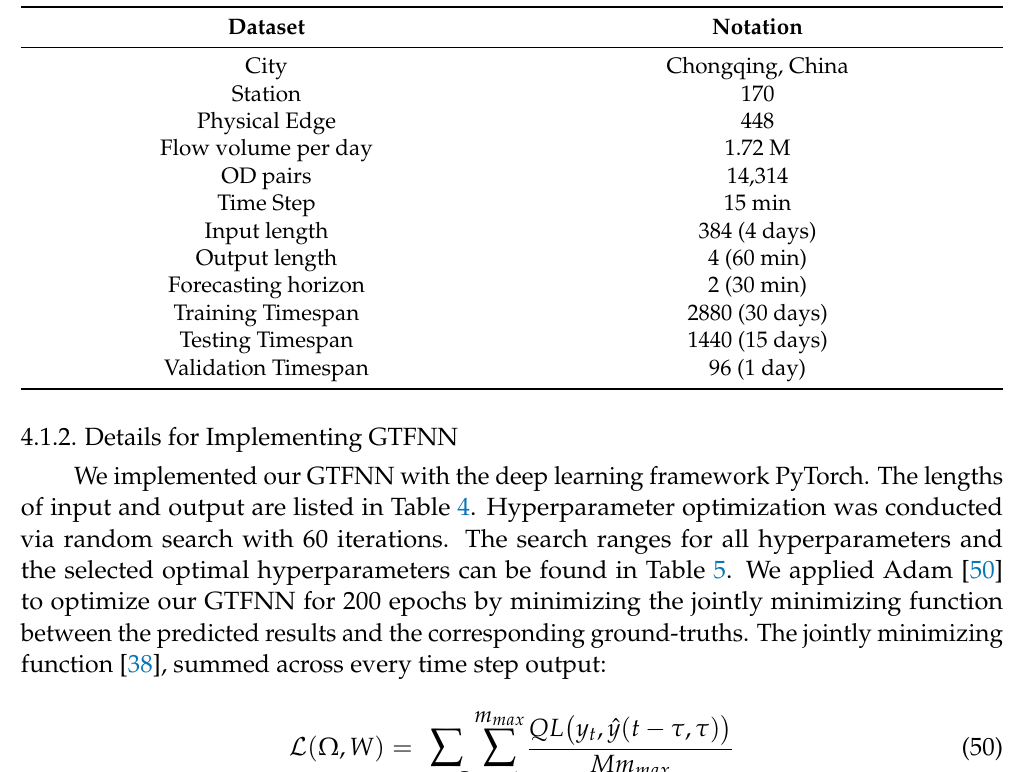
Table 4. Dataset of CQMetro.